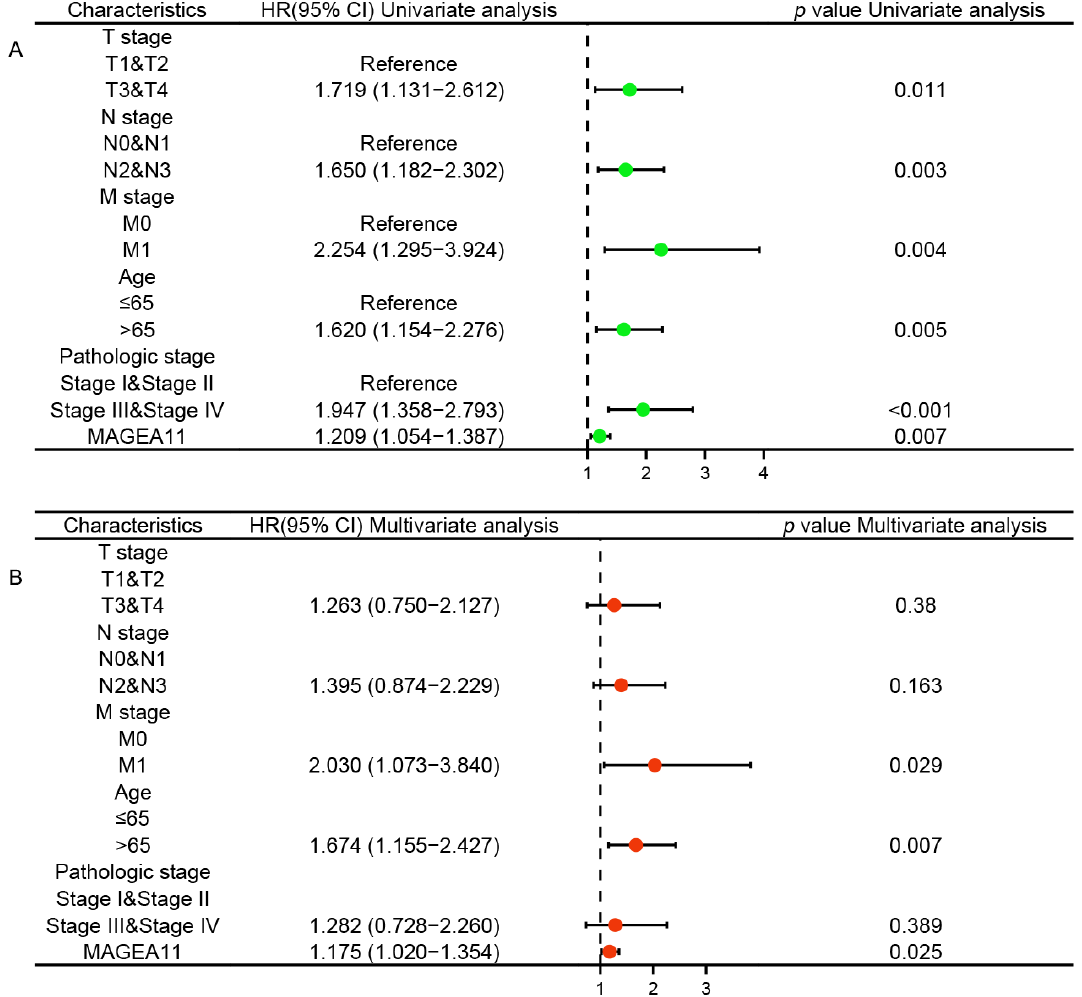
Figure 2. Cox regression analysis of MAGEA11 expression and related clinical features in overall survival of STAD patients. ( A ) Univariate Cox regression analysis. ( B ) Multivariate Cox regression analysis.